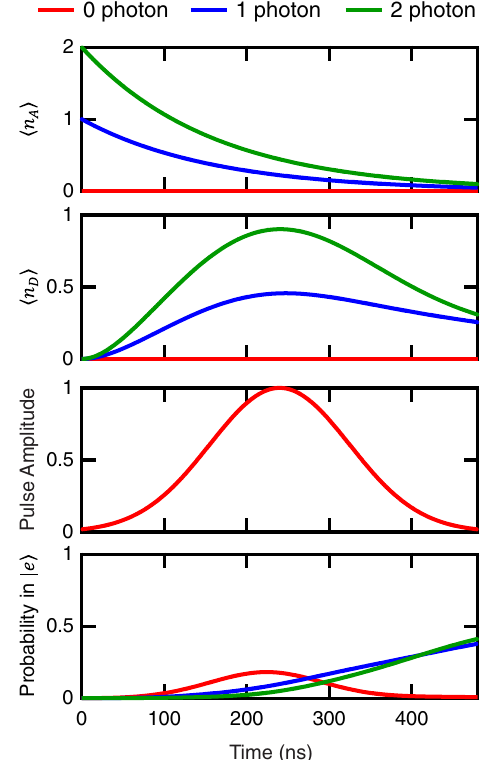
FIG. 9. Detector simulations. Results from solving the master equation for a cascaded quantum system of the Alice cavity emitting Fock states into the detector qubit-cavity system. The top two panels show the expectation value of the photon number operators of the Alice h n and detector h n cavities. The Alice A i D i cavity (top panel) was initialized in j 0 i (red trace), j 1 i (blue trace), or j 2 i (green trace). The third panel shows the amplitude of a selective π -pulse with σ ¼ 120 ns applied on the detector qubit to excite it, conditioned on the presence of a single intracavity photon. Finally, the probability to find the detector qubit in j e i was calculated to find P at the end of process (bottom panel). click Simulations confirm that the detector has dark counts ( P given click j 0 i ) P d < 0 . 01 and an efficiency ( P click given j 1 i ) η ∼ 0 . 4 . Since P is the same for j 1 i (blue trace) and j 2 i (green trace), the click detector is not number resolving.